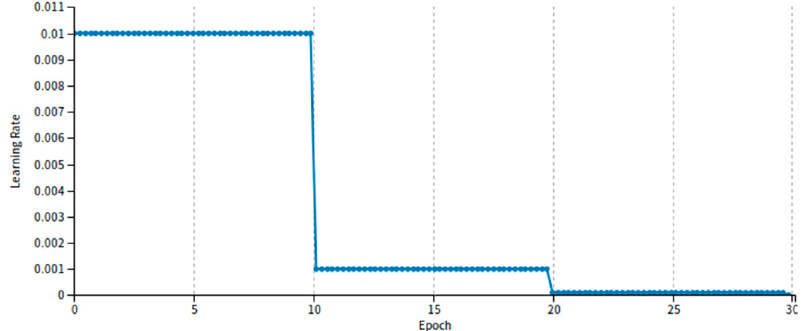
Figure 5. The changes in the value of learning rate with increasing training epoch on the KITTI dataset.